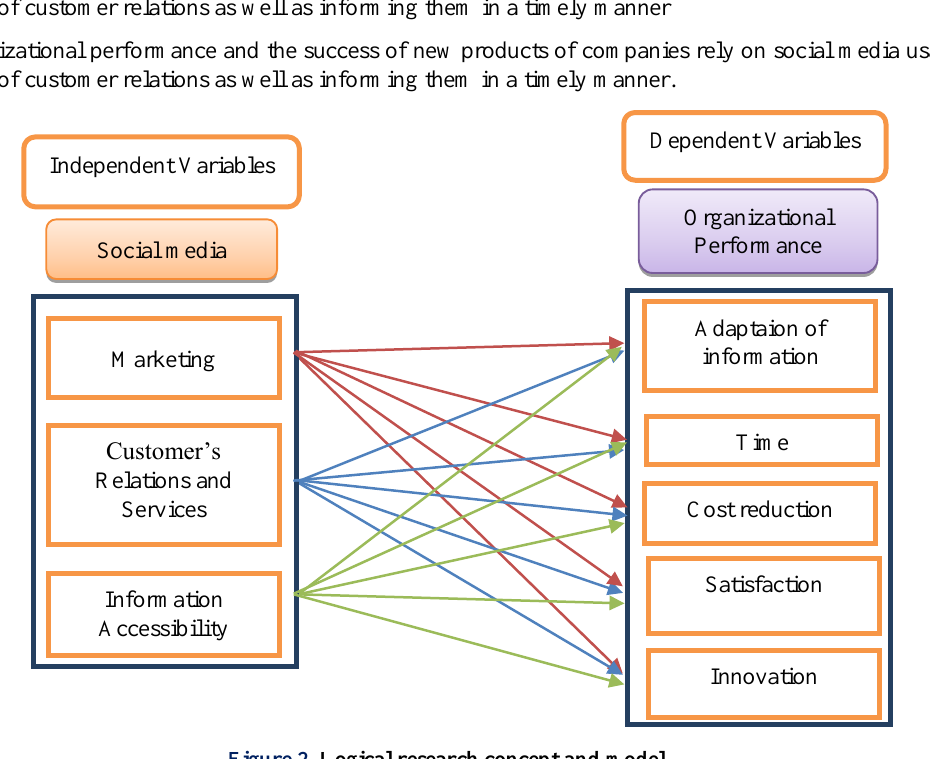
Figure 2. Logical research concept and